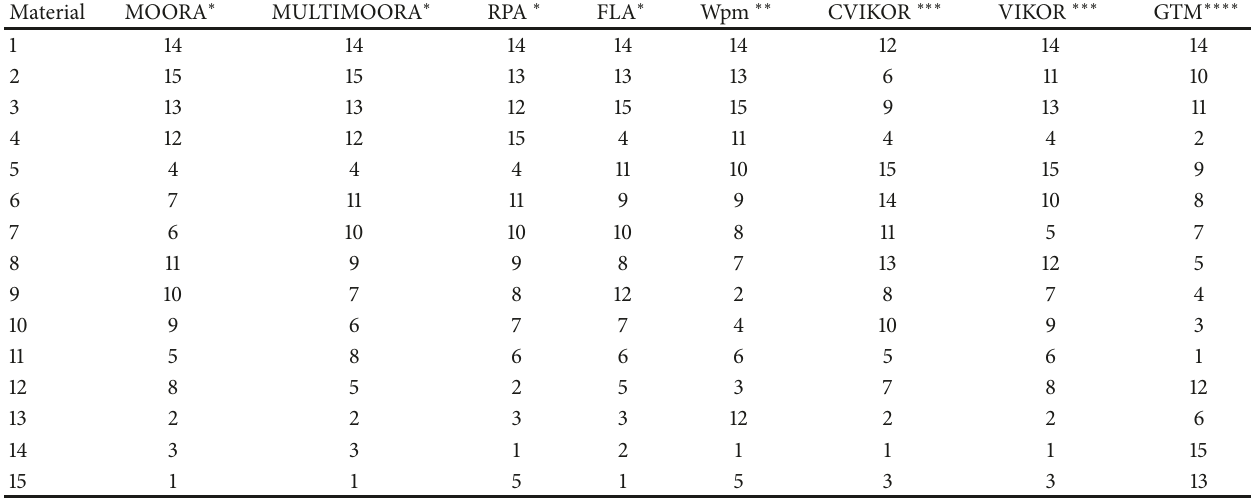
Table 5: Materials ranked by comparable